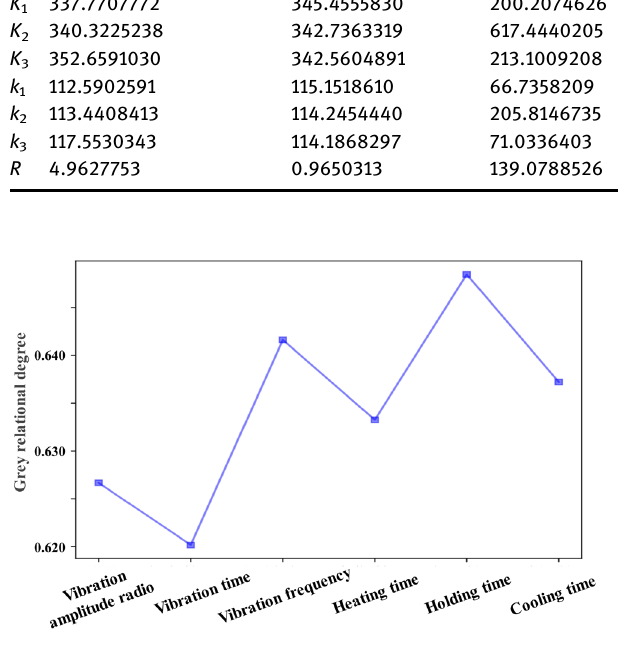
Figure 9: Gray correlation degree of maximum equivalent stress.